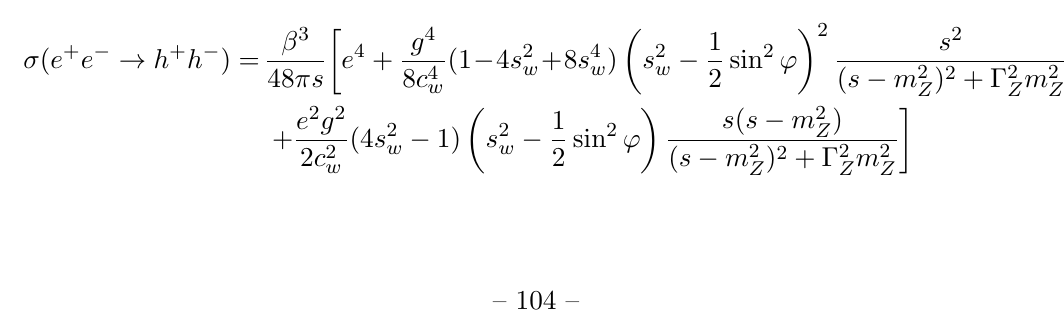
Figure 59 . Summary of maximum NSI strength neutrino mass models discussed here. Red, yellow, green, cyan, blue and purple bars correspond to the Zee model, minimal radiative inverse seesaw model, LQ model with singlet, doublet and triplet LQs, and Zee-Babu model